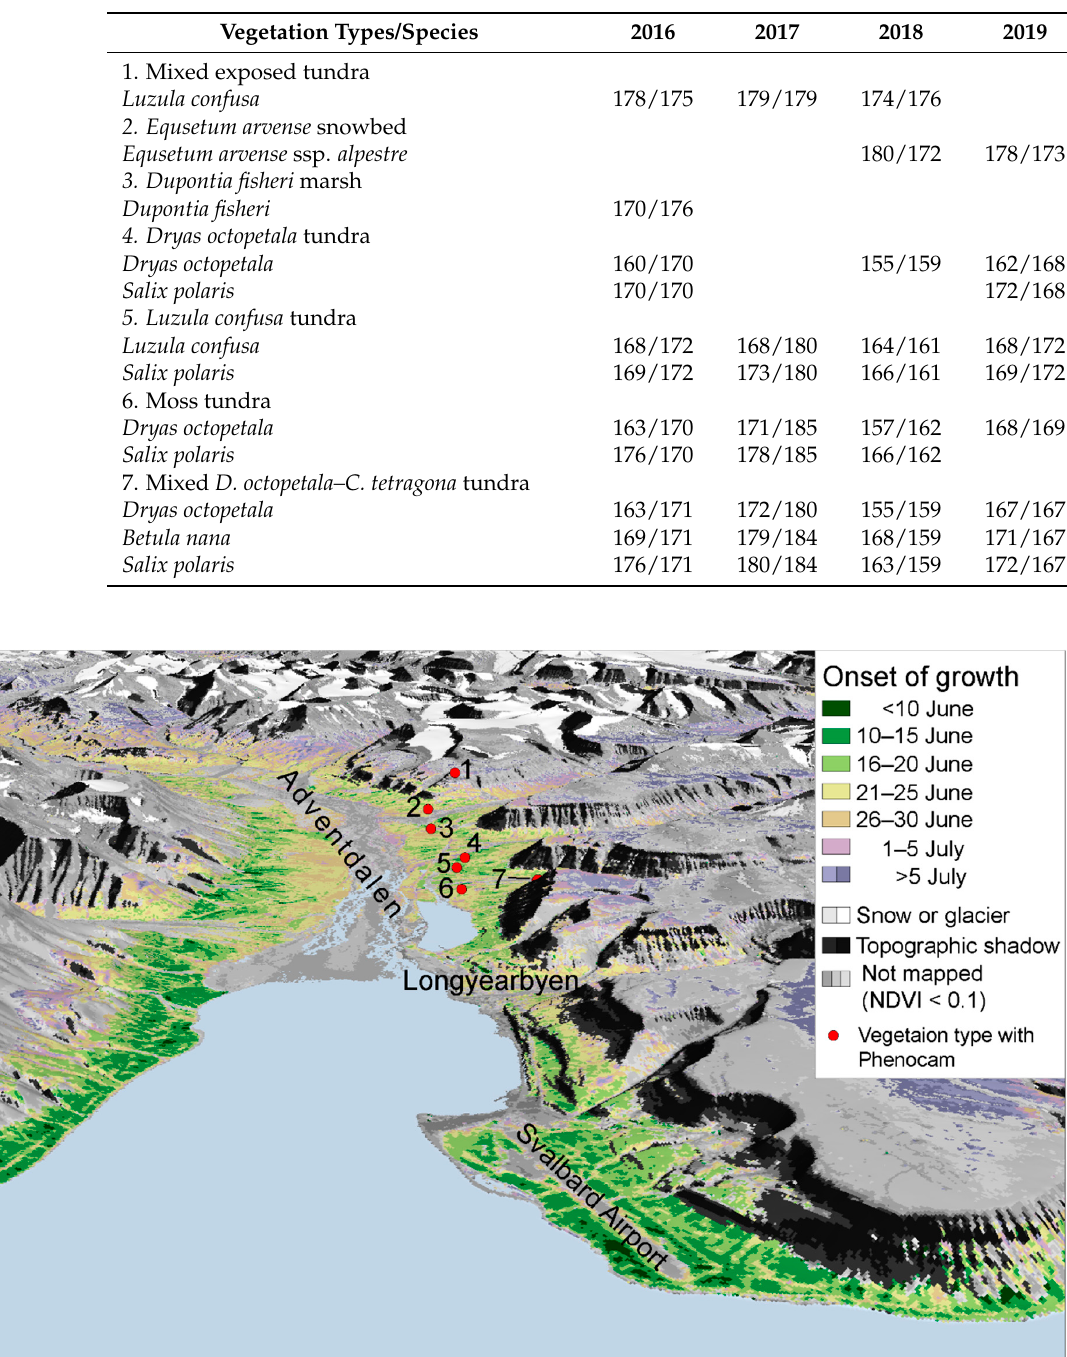
Table 2. Onset of growth (day of year) as measured from phenocams (left value), and from S2 NDVI (right value) for the seven polygons representing seven vegetation types, see location in Figure 5.